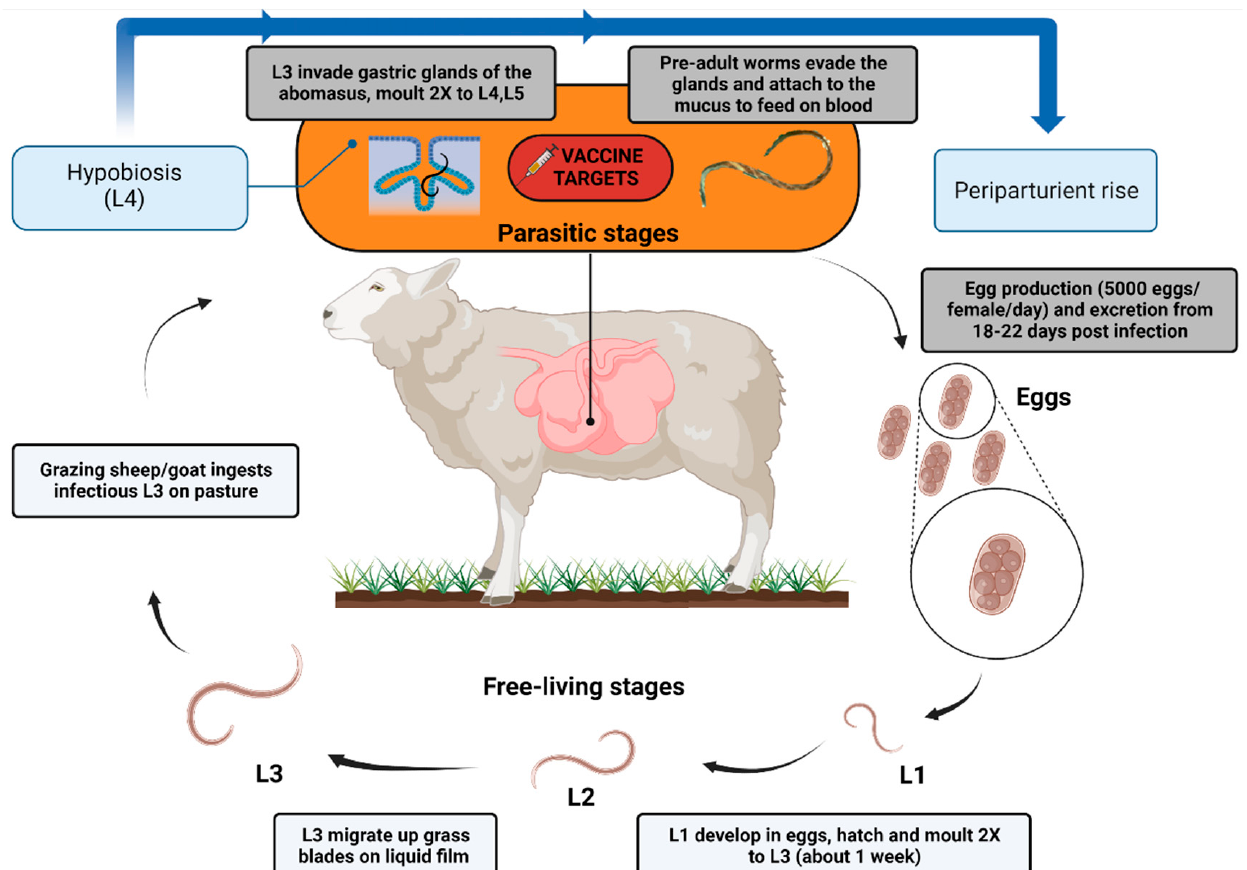
Figure 1. The life cycle of Haemonchus contortus in sheep. [Created with BioRender.com, accessed on 21 June 2022].